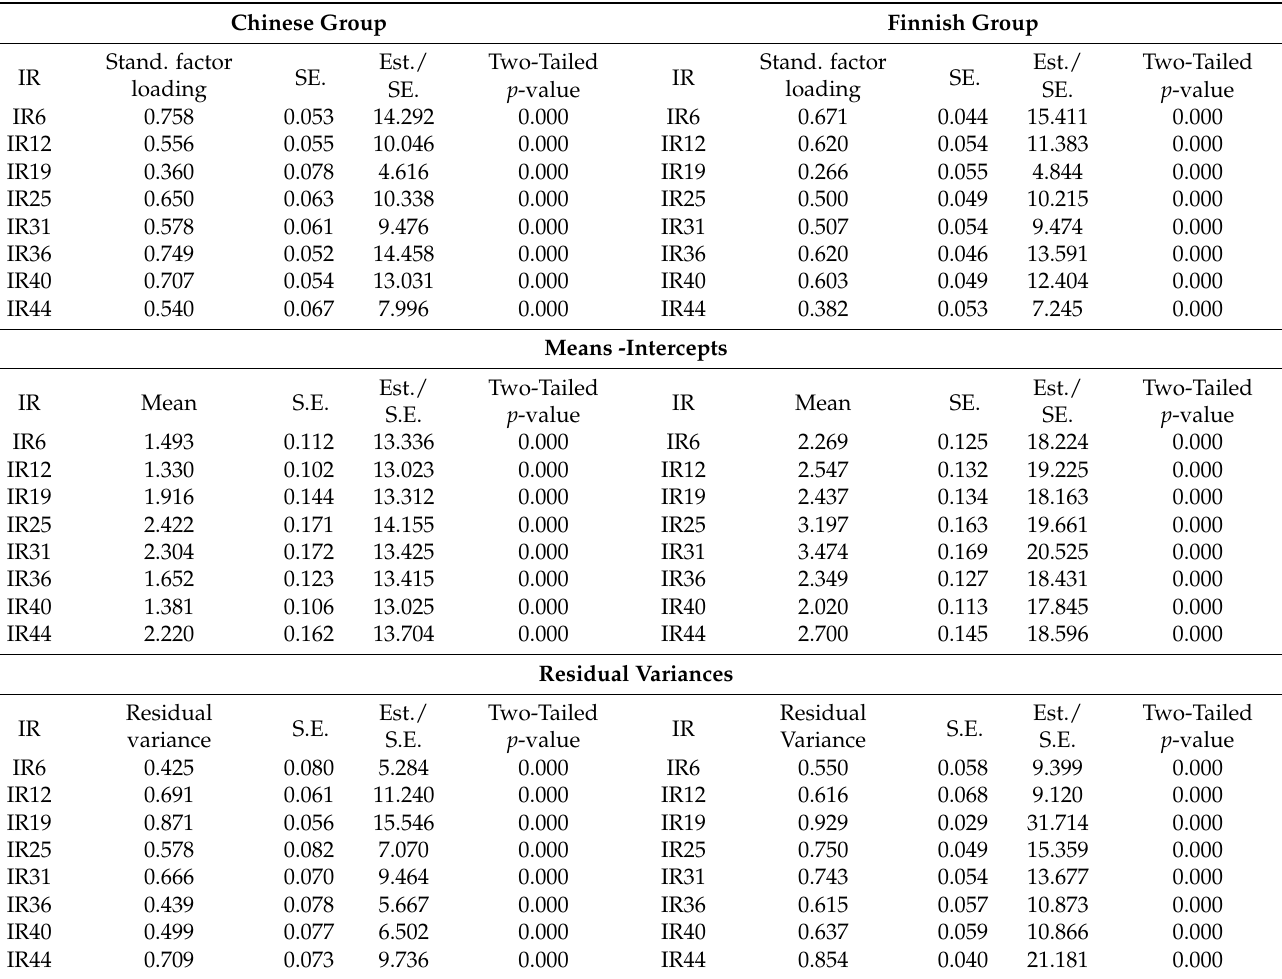
Table 3. Irrelevance latent variable—strong factorial